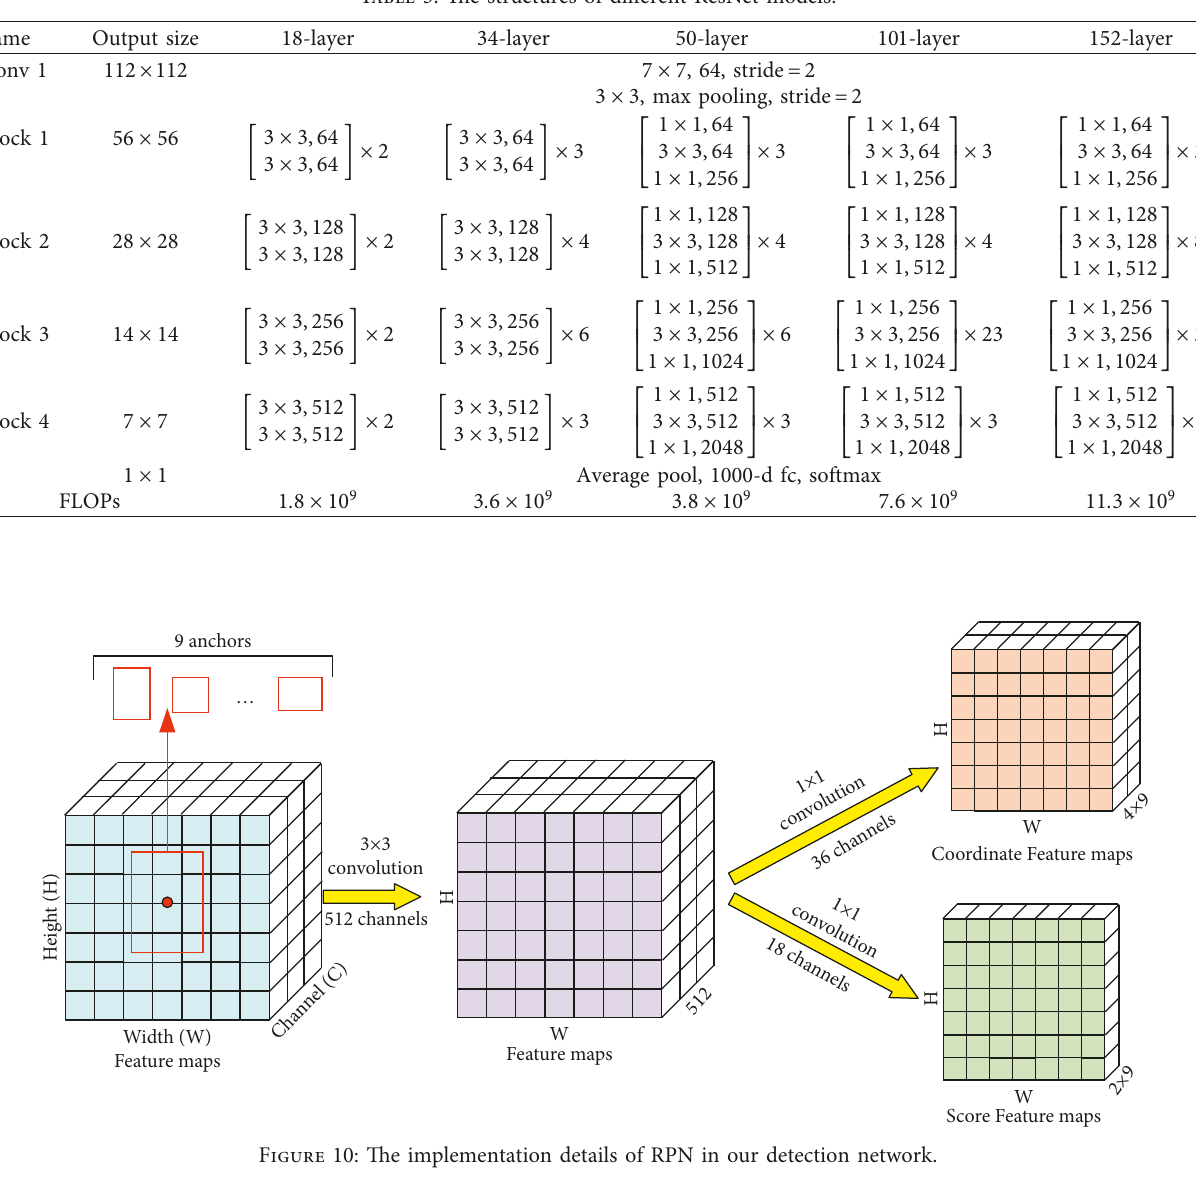
Table 3: The structures of different ResNet models.